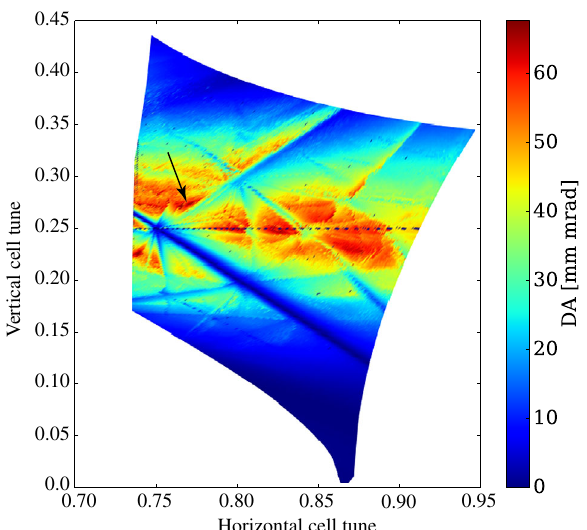
FIG. 5. The DA is shown in the tune space for an error free NORMA ring lattice. The DA is represented by a color spectrum with higher DA appearing in red and lower DA toward blue. The darkest blue points represent dynamically unstable lattices, for example those along the systematic resonance at vertical tune of 0.25. The black arrow indicates the region containing the highest DA. Due to the strong sextupole resonance at horizontal cell tune 0.66, the DA is only shown from around 0.73 onward. Over 1 × 10 4 individual calculations exist within this plot, allowing high resolution analysis.